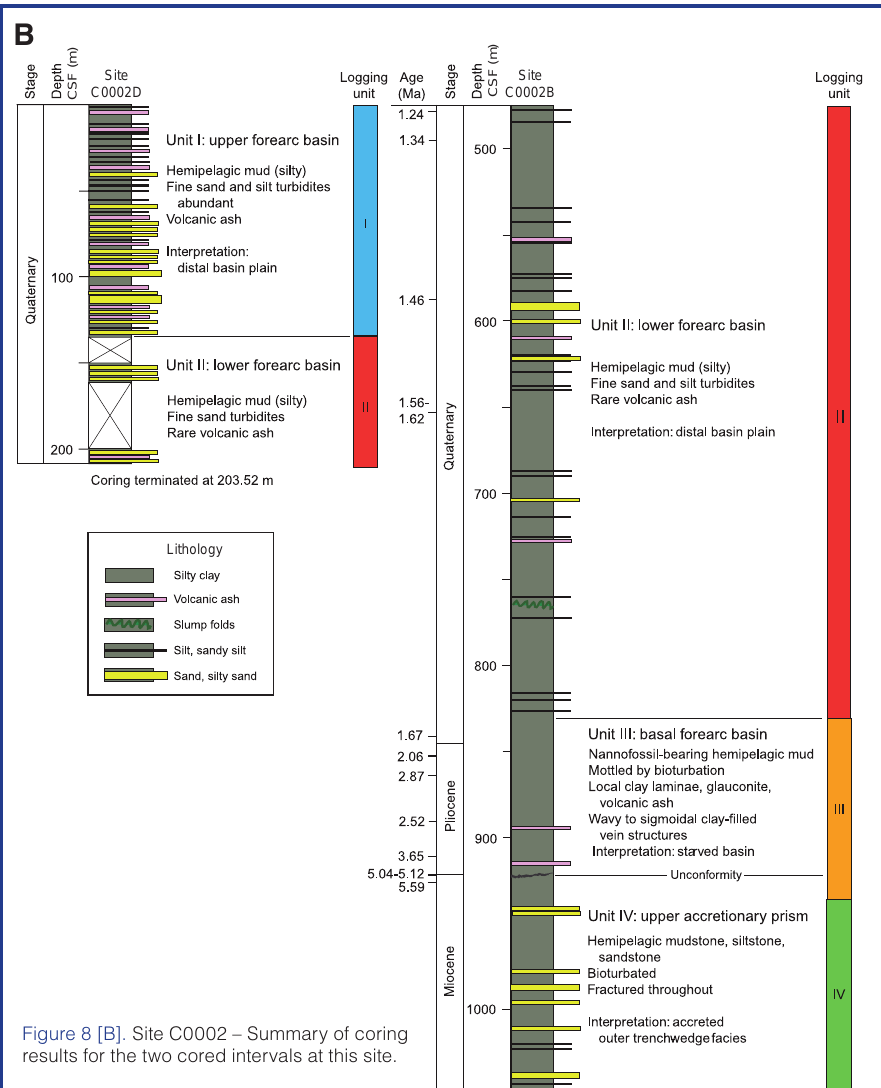
Figure 8 [B]. Site C0002 – Summary of coring results for the two cored intervals at this